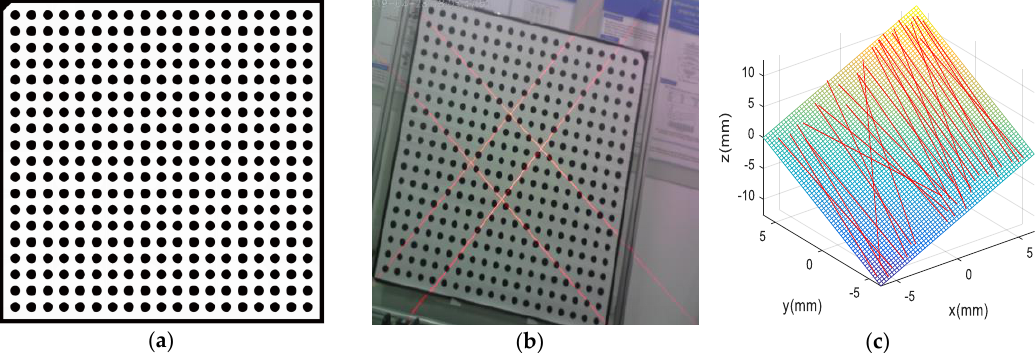
Figure 8. Calibration of the visual sensor: ( a ) circle calibration target; ( b ) calibration image; and, ( c ) laser plan fitting.